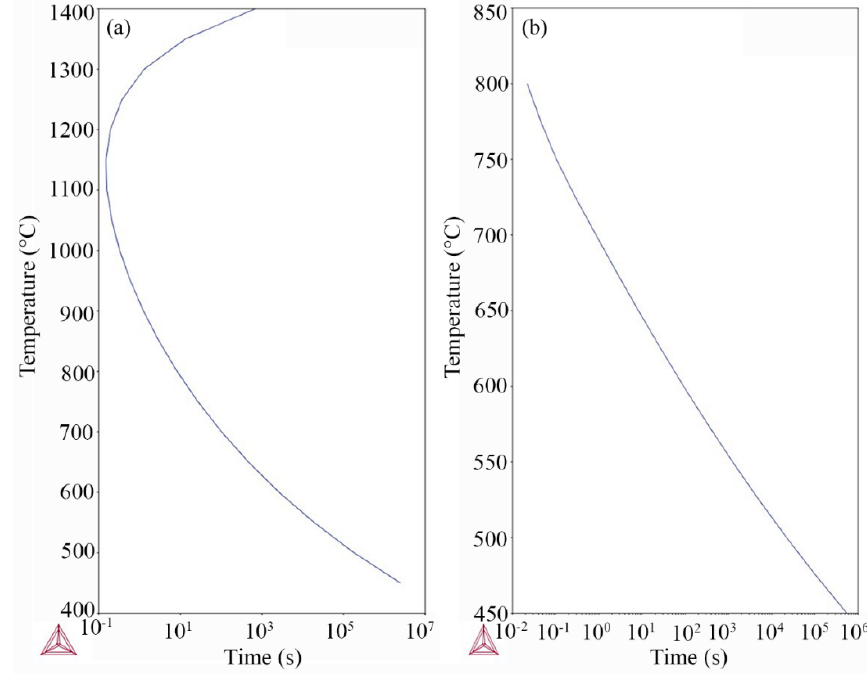
Figure 3. Time–temperature–precipitation (TTP) diagrams of ( a ) Ti(C, N); ( b ) MoC.